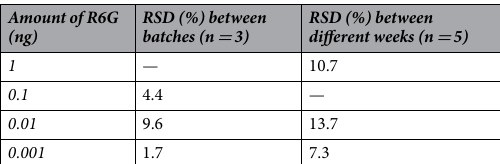
Amount of R6G (ng)